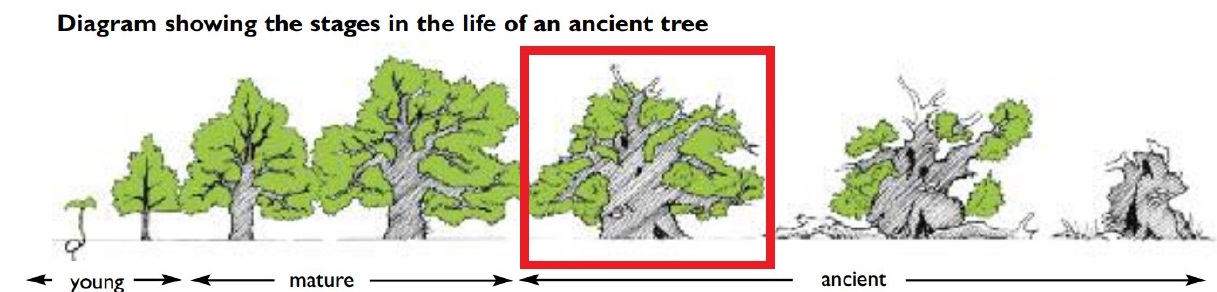
Figure 5. The course of tree growth according to Ancient Tree Forum [4] with the selected studied phase of the growth framed.